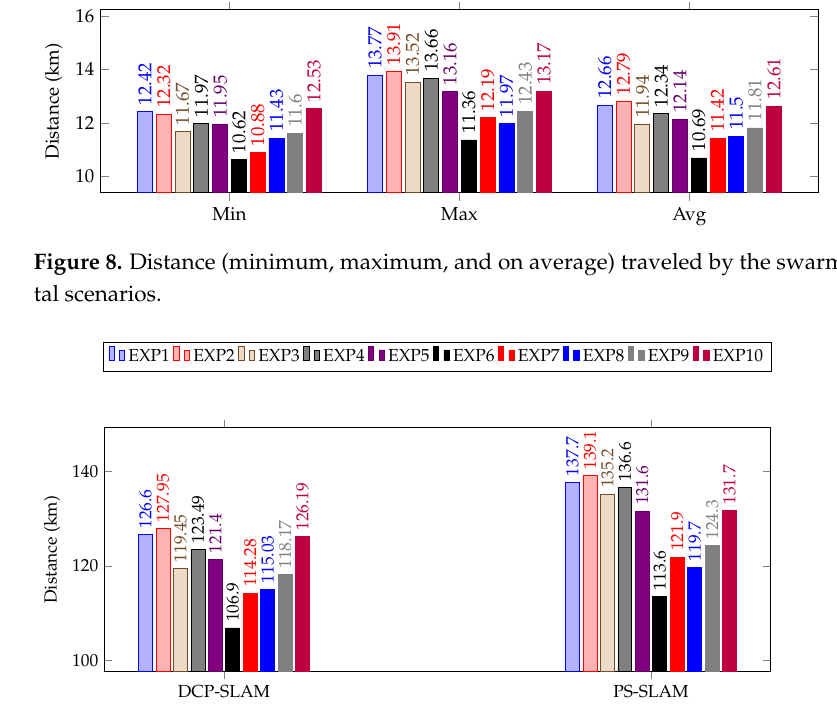
Figure 8. Distance (minimum, maximum, and on average) travelled by the swarm in all experimental scenarios